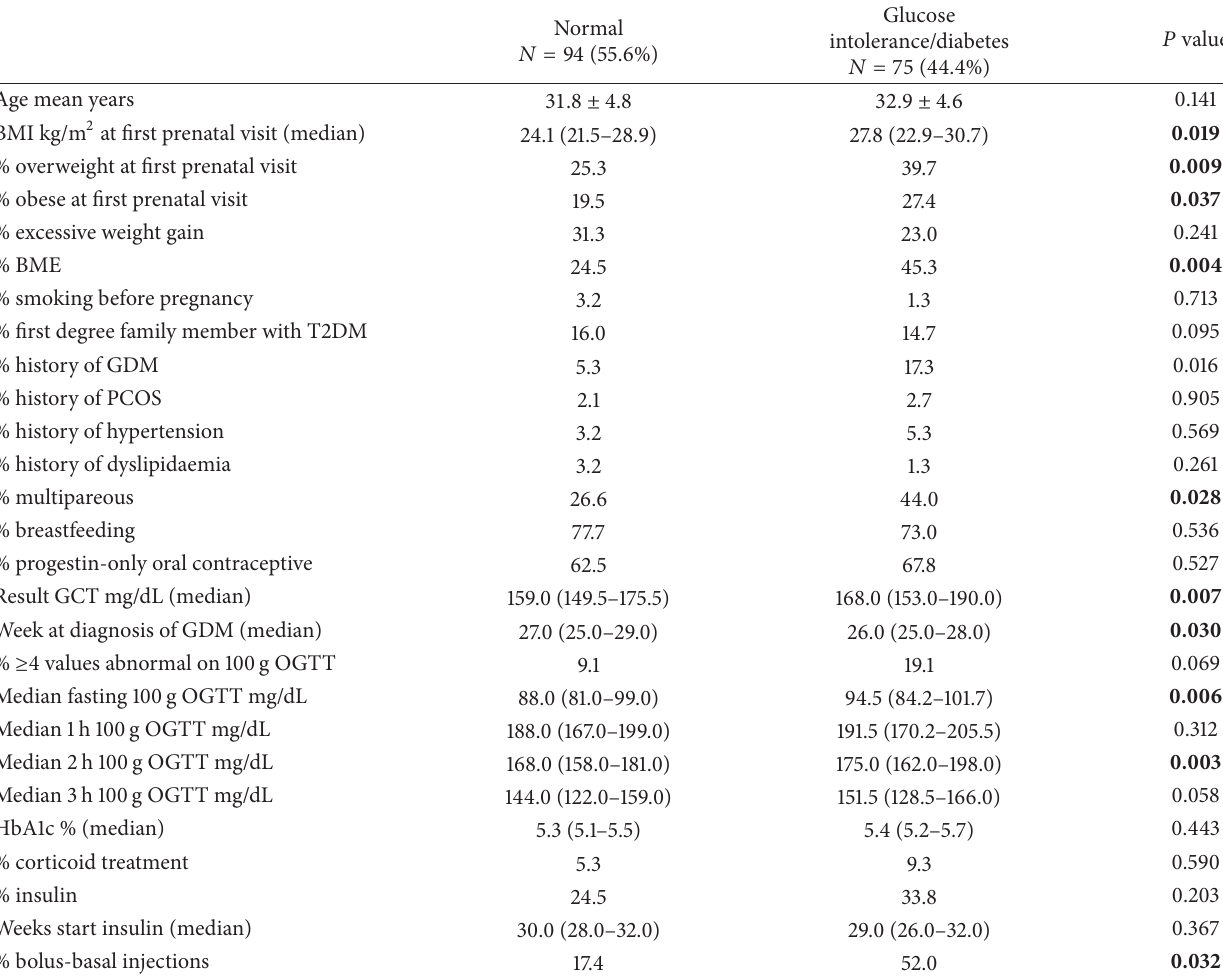
Table 2: Comparison of the characteristics between women with a normal OGTT and women with glucose intolerance/diabetes postpartum.